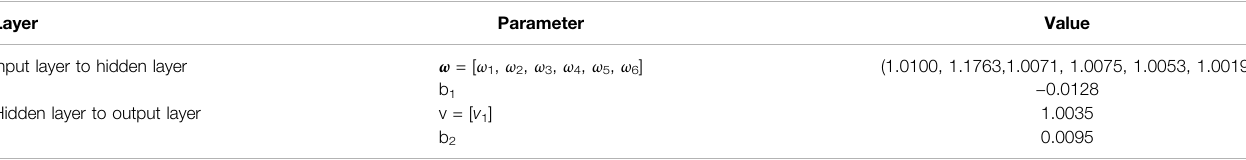
TABLE 3 | The parameter results from the proposed modi fi ed BP neural network.